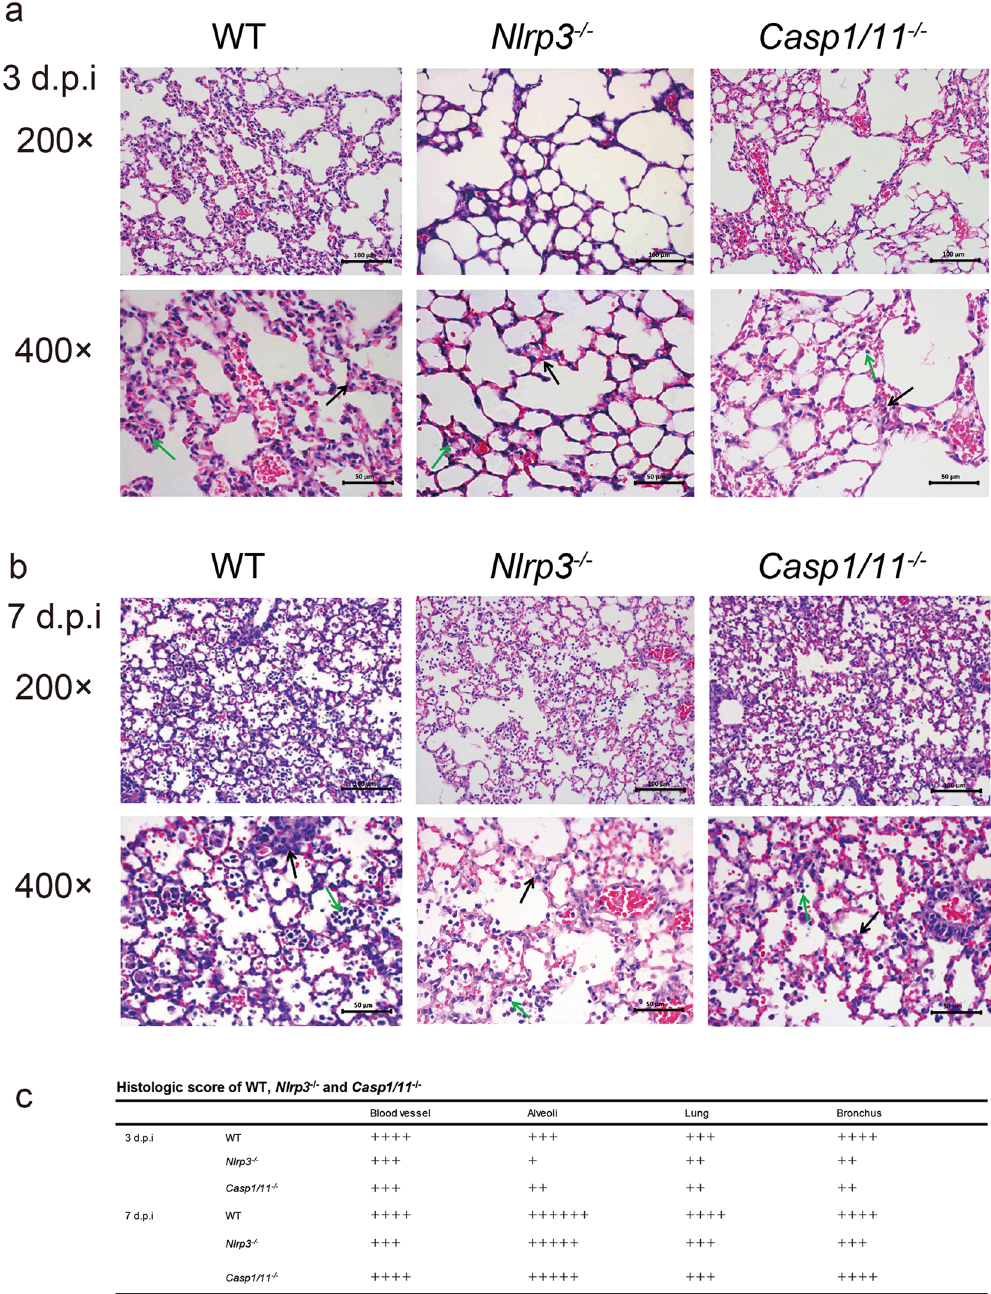
Figure 3. Deficiency of NLRP3 or caspase-1 decreases pulmonary inflammation during H7N9 infection. WT, Nlrp3 − / − or Casp1/11 − / − mice were infected as in Fig. 2 and the lungs were harvested on 3 ( a ) or 7 ( b ) days post infection (d.p.i), then the tissues were fixed and processed for H&E staining and microscopy. The original magnification of the top panels and the bottom panels are 200 × and 400 × (with the corresponding scale bar on the images). In the 400 × magnification, the black arrows indicate the thickening of alveolar septum and the green arrows show inflammatory cells infiltration. ( c ) For scoring results of pulmonary pathology of WT, Nlrp3 − / − and Casp1/11 − / − mice, 4 slides from each mouse were monitored. 6 mice representing each genotype were examined at indicated time points. Data are representative of three independent